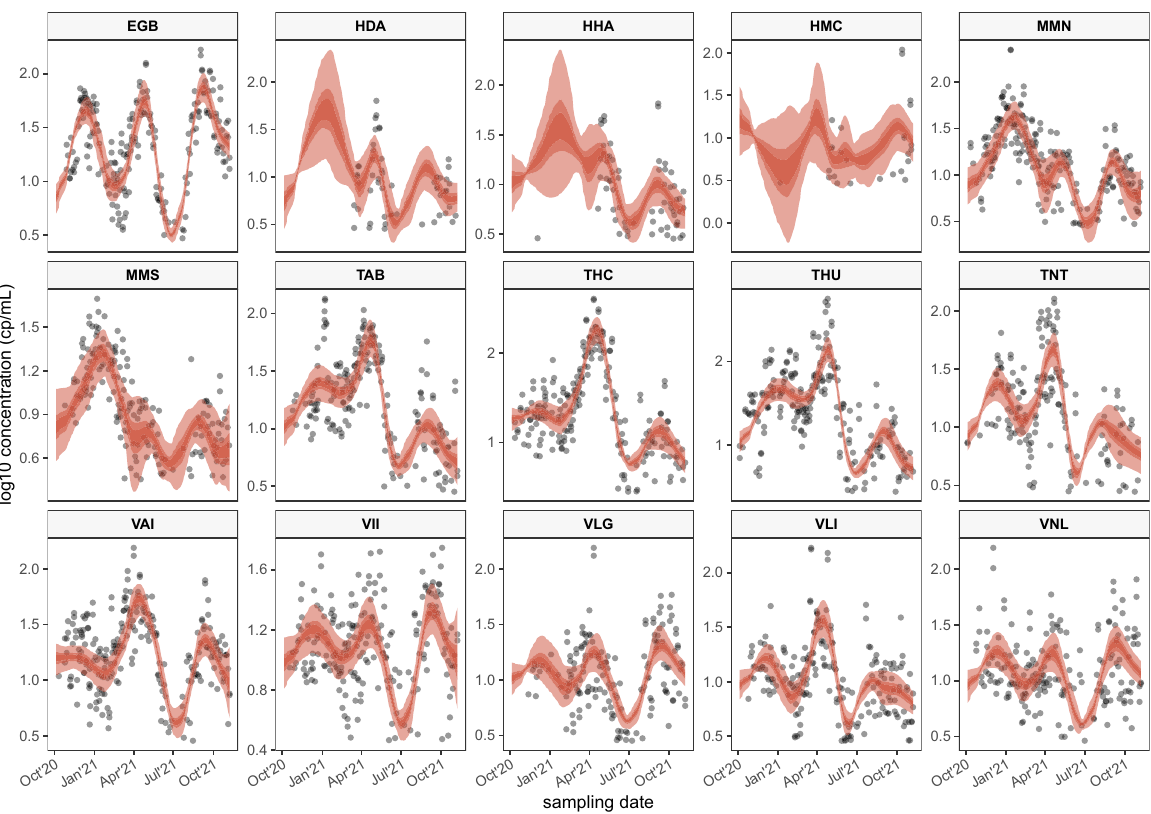
Figure 1. Black open circles represent the Log10 transformation of SARS-CoV-2 concentration observations for the N1 assay. Red shaded areas represent the range (lightest area), 50% (darkest area) and 80% credible intervals (slightly lighter area) of posterior curves at each date, from the model with covariates. Each panel represents a sampling